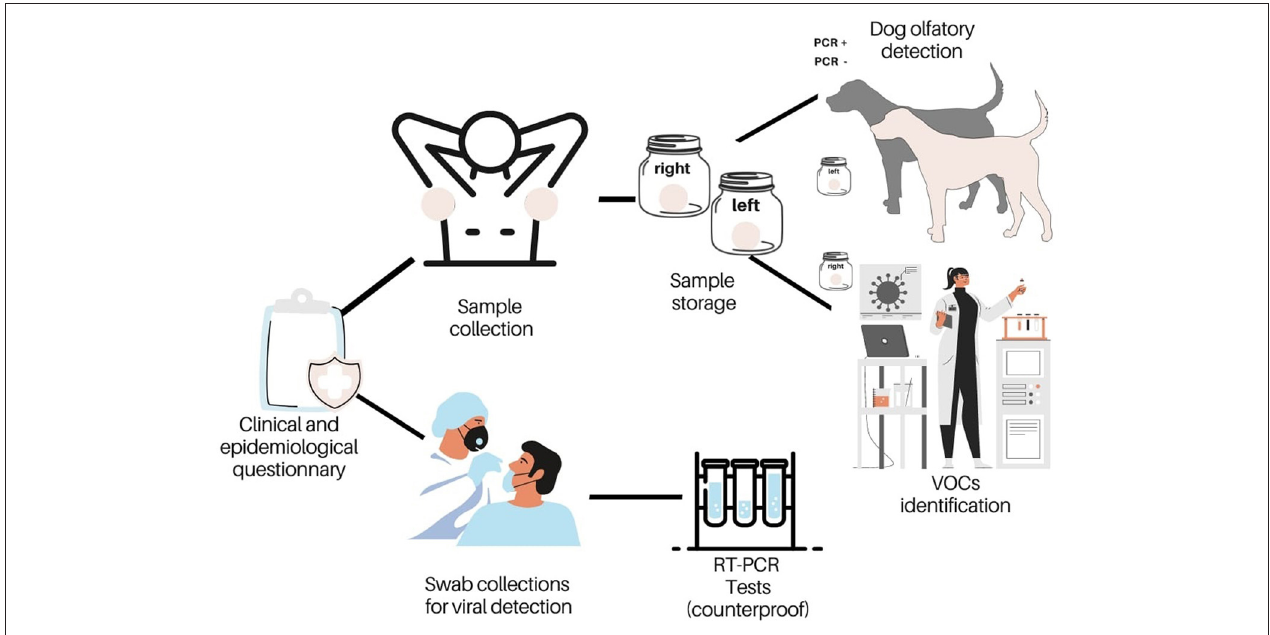
FIGURE 1 | Schematic representation depicting sample